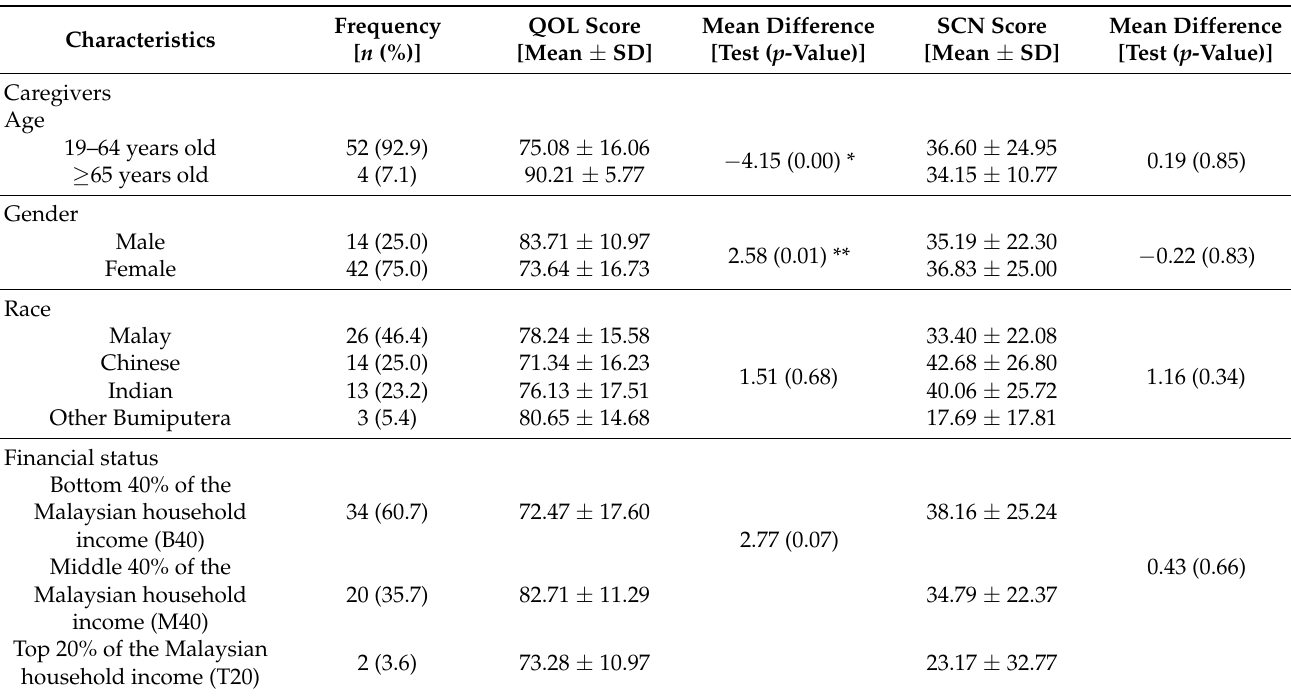
Table 1. Participant demographic profiles, quality of life, and supportive care needs